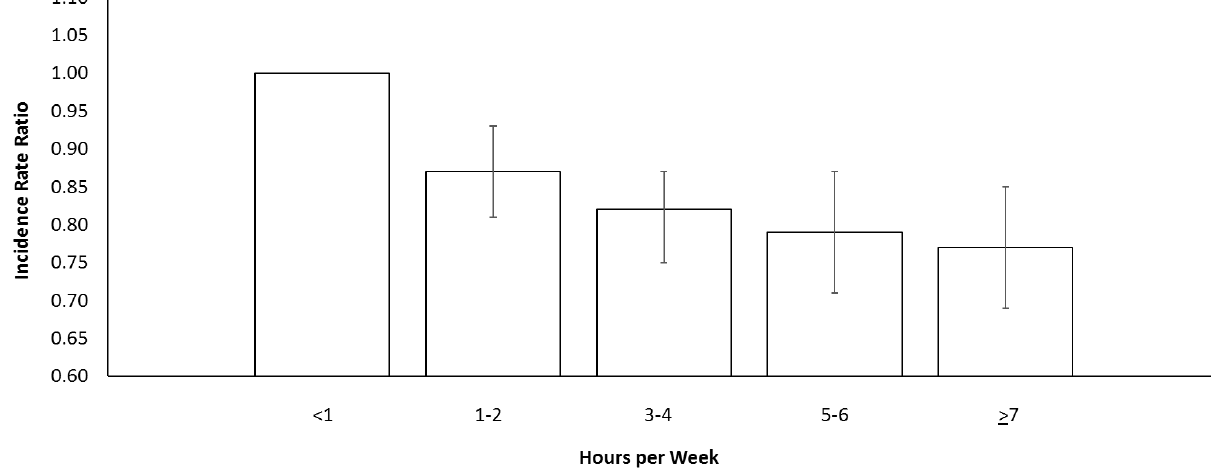
Source: Adapted from data found in Rosenberg et al., 2013.